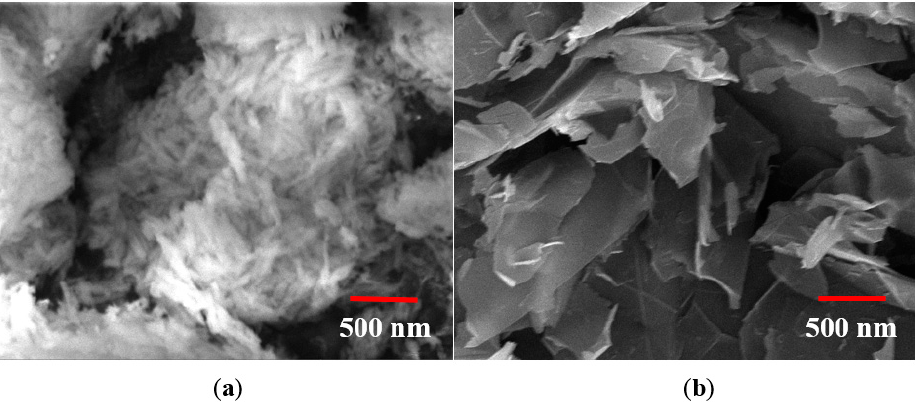
Figure 1. SEM images: ( a ) HNT; and ( b ) MLG.